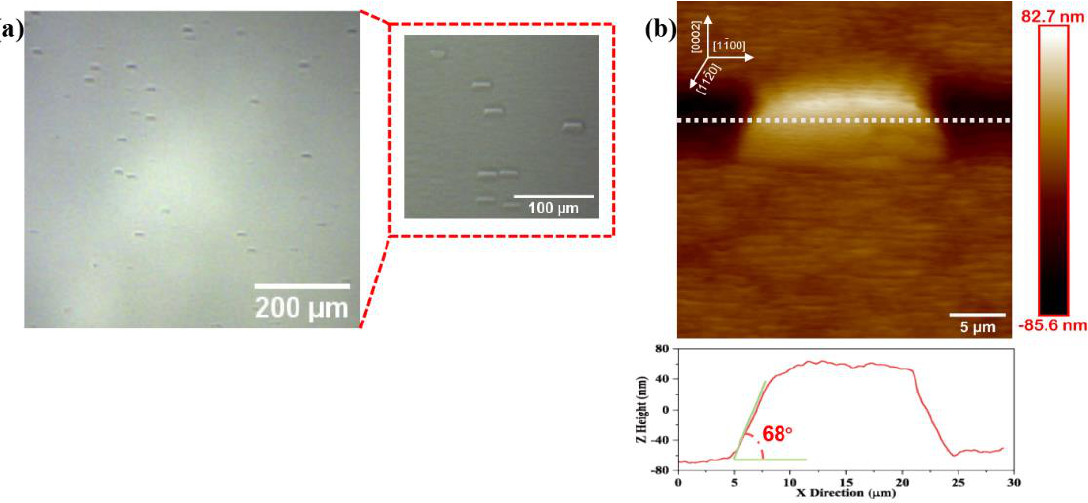
Figure 2. ( a ) Optical microscope image of the surface of an AlN sample annealed at 1700 °C; ( b ) AFM image of volcano-like protrusions on the surface of an AlN sample annealed at 1700 °C.